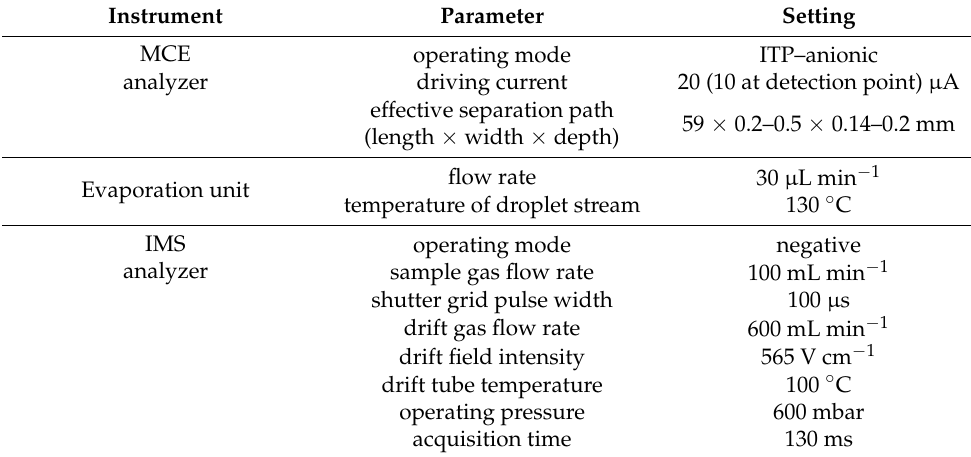
Table 3. Parameters of the instrumentation for the µ ITP-IMS